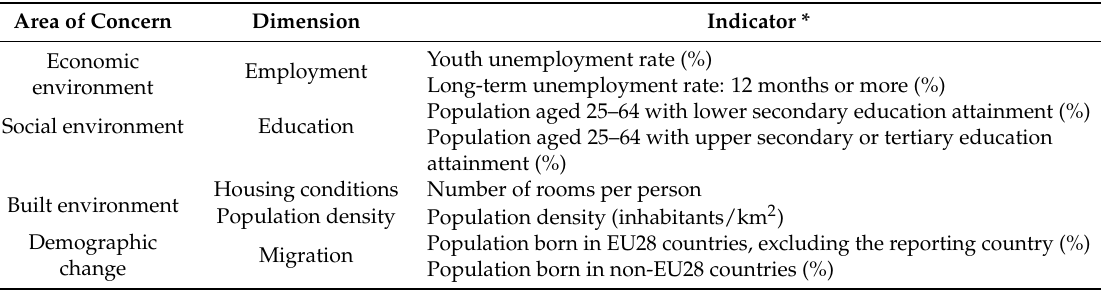
Table 1. Health Determinants